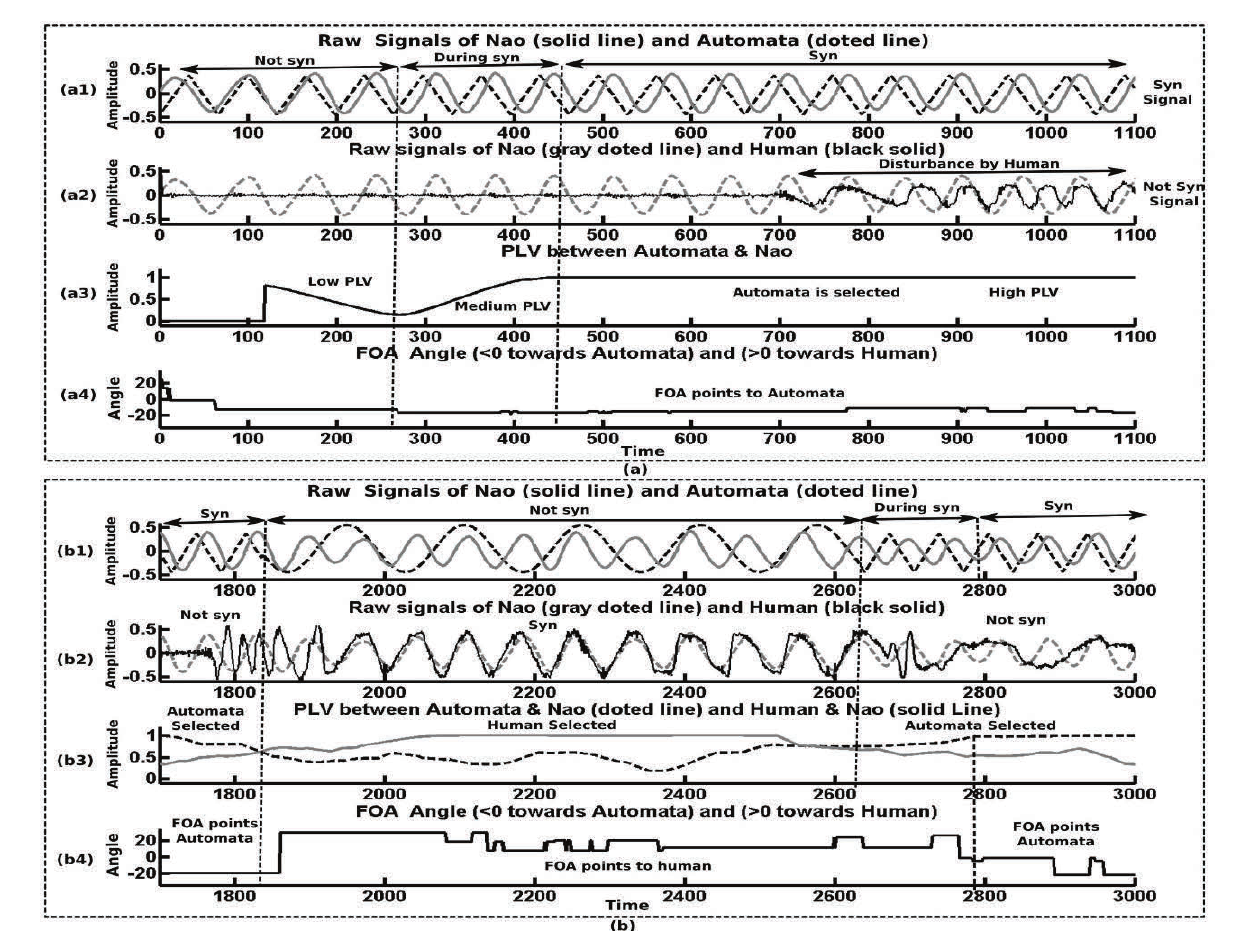
Figure 10. Results: Every set has 4 graphs with same sequence where first time series of every set shows the raw signals of Nao oscillations along with robotic arm while second contains raw signals of Nao along with human and third time series shows the PLV (quality of synchrony) for the pairs of interacting agents and finally, forth shows the FOA angle of Nao which follows the synchronized region. (a) shows start of experiment with single agent and then disturbed by the other agent. (b) Multiple agent having di(cid:636)erent frequencies interact (one of them with same as Nao) and Nao always selects similar frequency